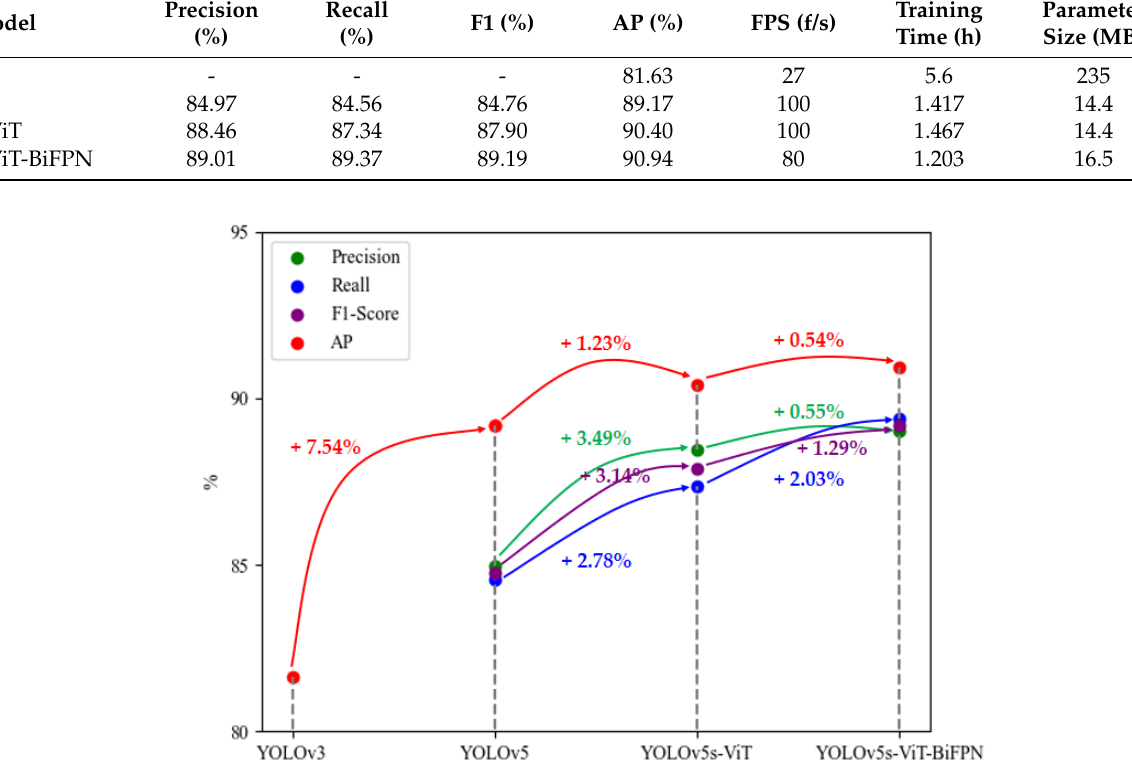
Figure 13. Accuracy comparison for the performances of the four models based on the metrics Precision (%), Recall (%), F1 (%), AP (%).